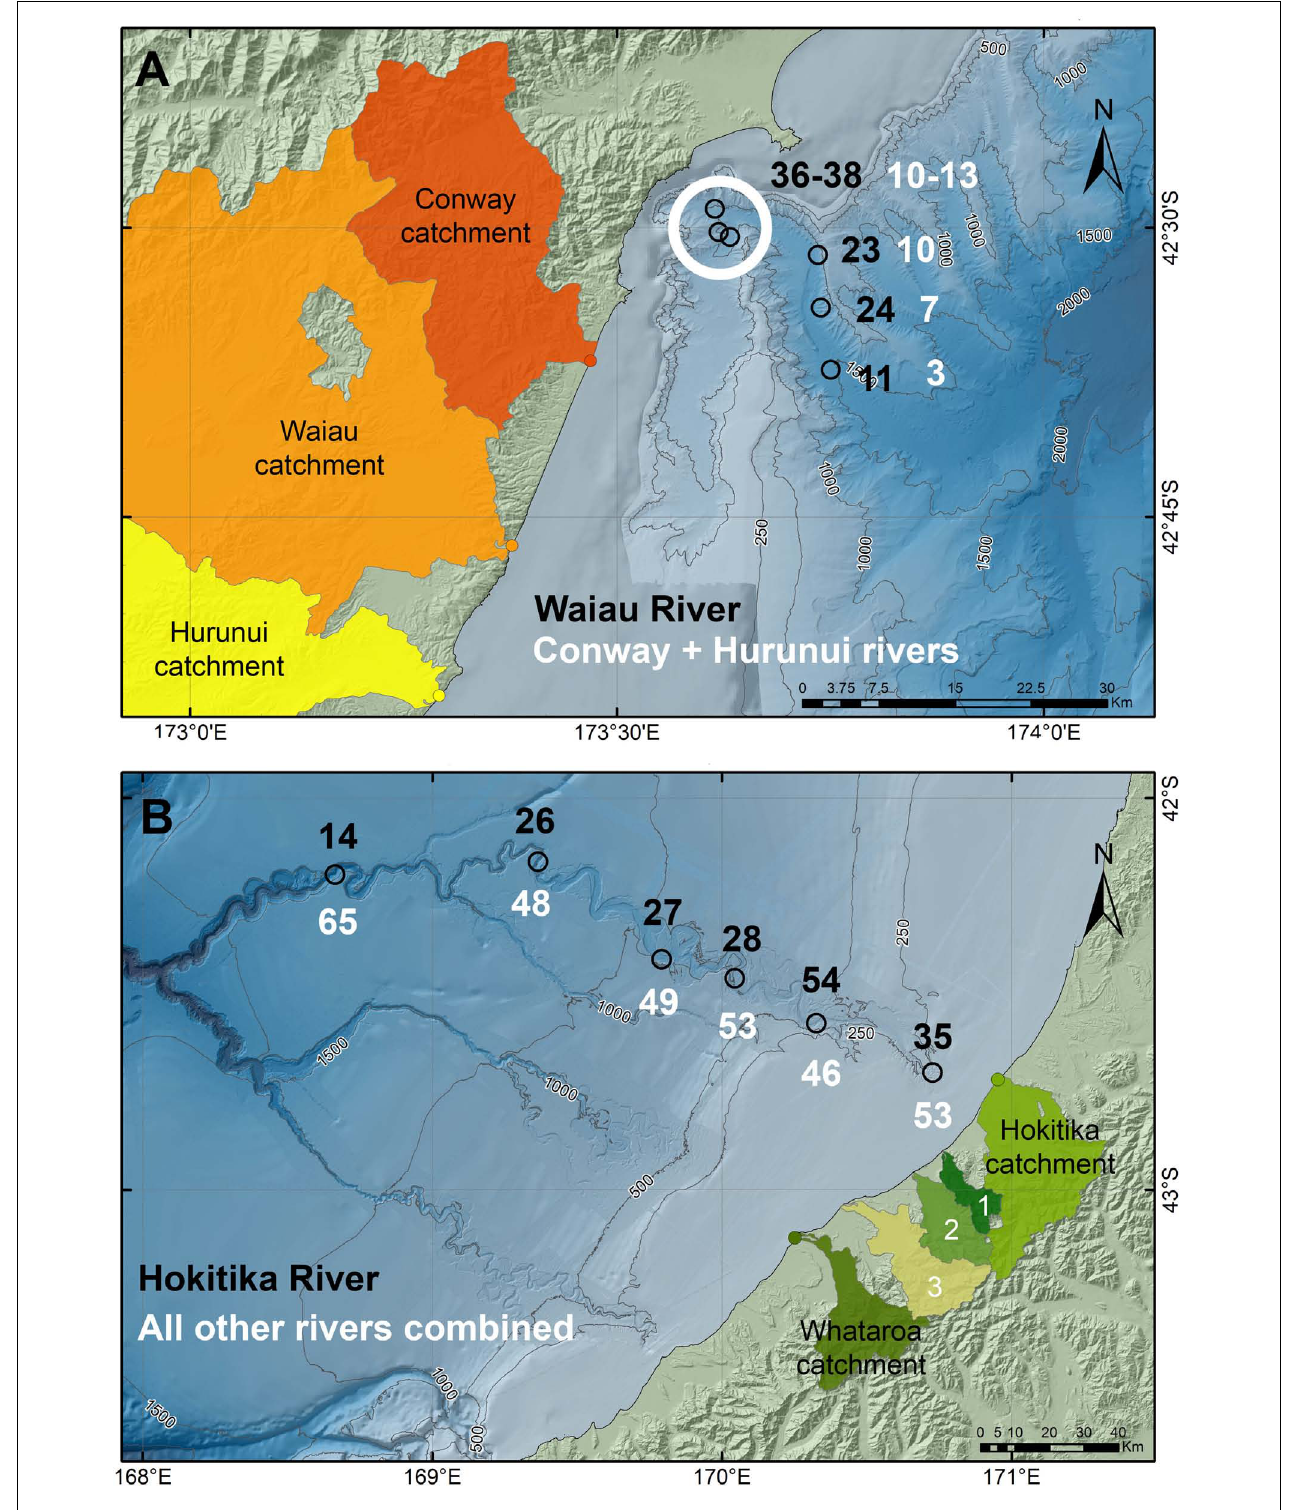
FIGURE 6 | Spatial proportional contribution of terrigenous organic material from the river inflows in: (A) Kaik¯oura Canyon, showing the proportional contribution from the Waiau River relative to the river inputs combined, and (B) Hokitika Canyon, showing the proportional contribution from the Hokitika River relative to the other river inputs combined. Results are mean values with error terms of ± 0.7–20% as standard deviations about the mean (errors not shown for clarity). Numbered river catchments are: (1) Mikonui, (2) Waitaha, and (3) Wanganui.